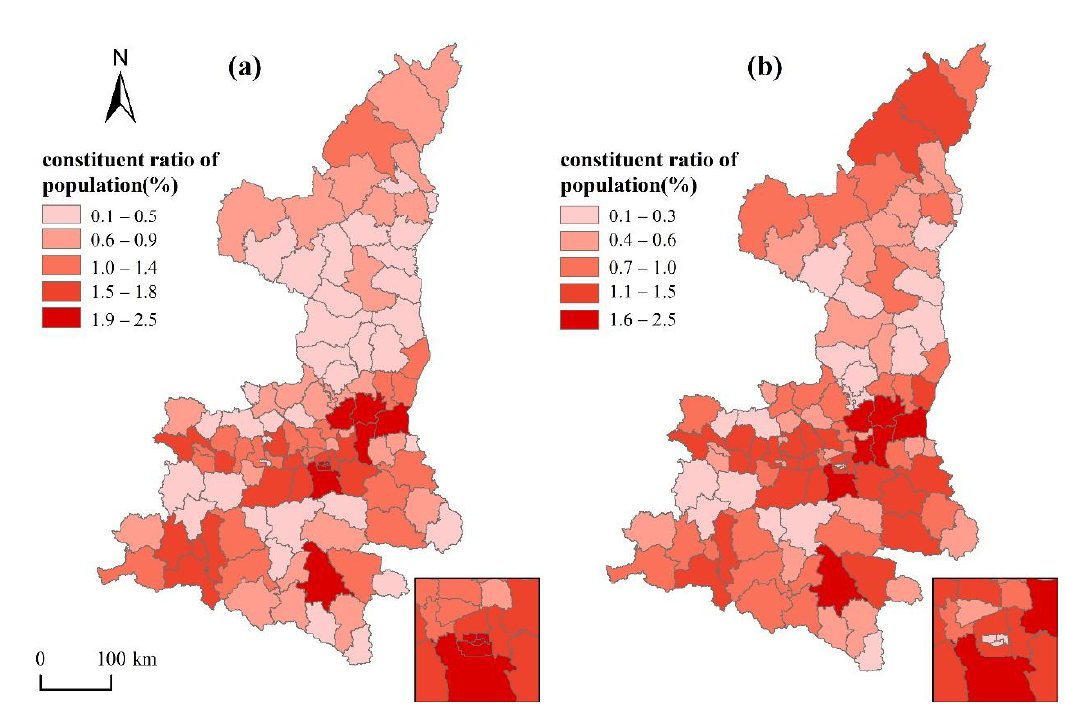
Figure 6. Spatial distribution of ( a ) aging and ( b ) agricultural populations.